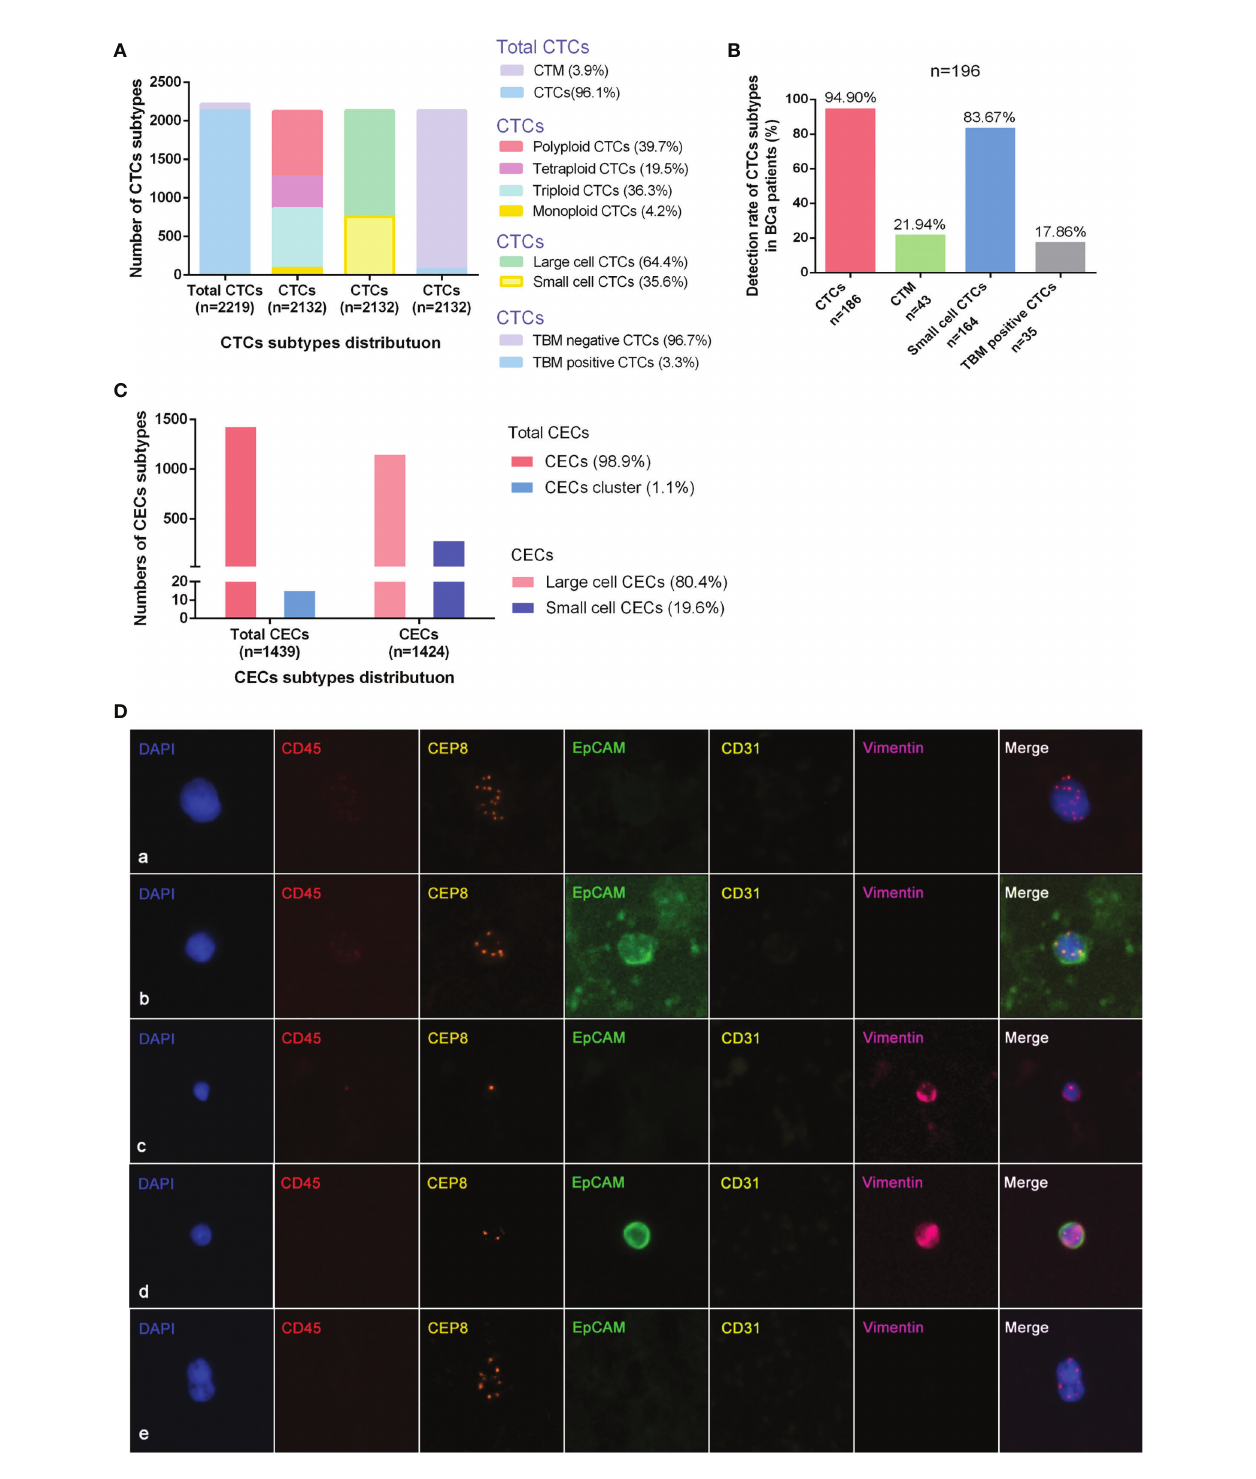
FIGURE 1 | Detection + and characteristics of CTCs and CECs by SE-iFISH in bladder-cancer patients. (A) Quantitative composition of diverse CTC subtypes among the total number of CTCs. (B) Detective rate distribution of CTC subtypes among all bladder-cancer patients. (C) Quantitative composition of CEC subtypes among the total number of CECs. (D) Identi fi cation of CTCs by SE-iFISH. Line a: Polyploid, large cell, and TBM negative CTCs; Line b: Polyploid, large cell, and TBM-positive (EpCAM + ) CTCs; Line c: Monoploid, small cell, and TBM-positive (vimentin + ) CTCs; Line d: Diploid, small cell, and TBM-positive (EpCAM + /vimentin + ) CTCs; Line e: